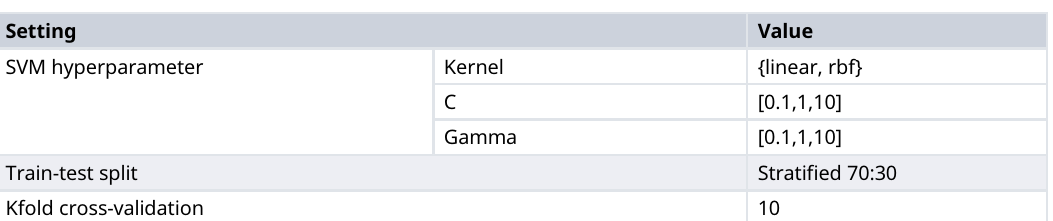
Table 5. The experimental setting